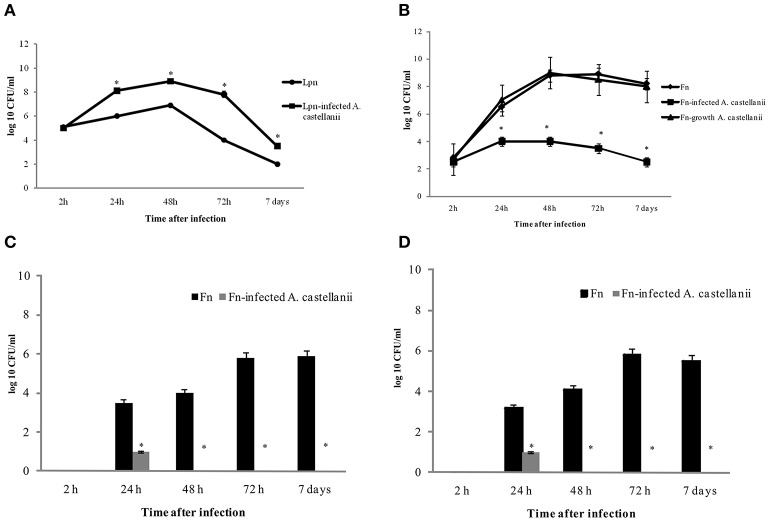
Growth kinetics of L. pneumophila and L. pneumophila-infected A. castellanii in lungs of A/J mice (A); F. novicida and F. novicida-infected A. castellanii in lungs (B), liver (C), and spleen (D) of Balb/c mice. At different time points after intratracheal infection of mice, organs were removed for determination of the number of bacteria (cfu) by plating serial dilutions on agar plates. The error bars represent standard deviations of triplicate samples and the results shown are representative of three independent experiments, *p < 0.05.